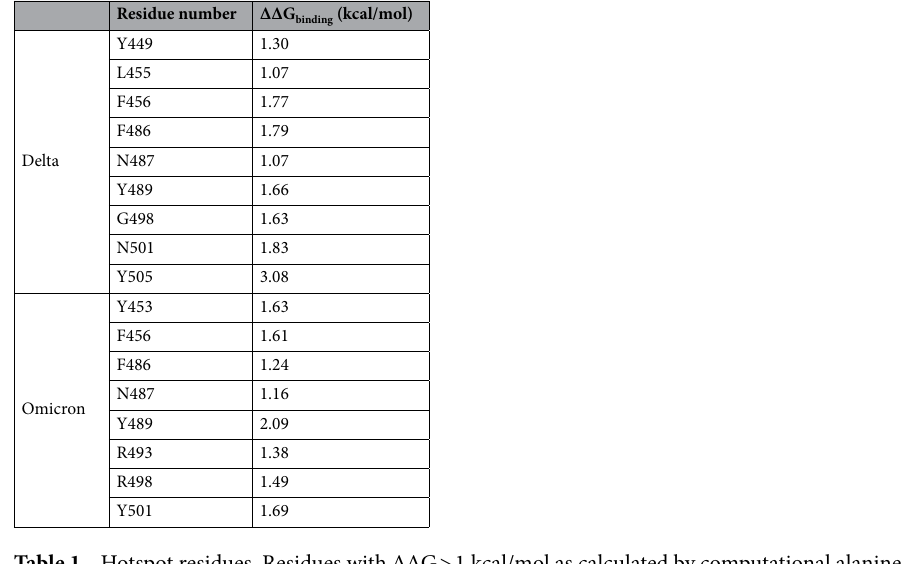
Table 1. Hotspot residues. Residues with ΔΔG > 1 kcal/mol as calculated by computational alanine